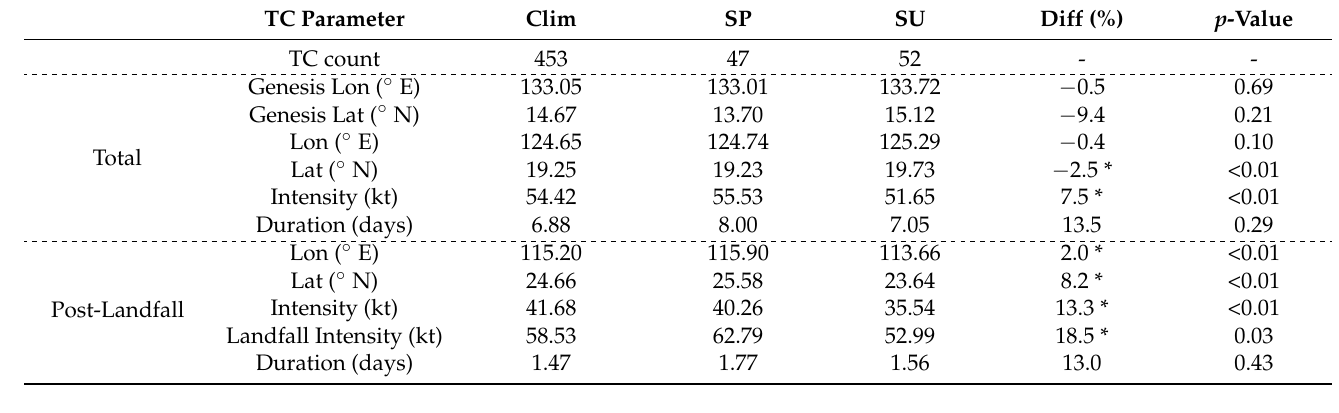
Table 1. The differences between the TC parameters of landfalling TCs in China during the typhoon season of SP and SU El Niño years. The total represents the entire track of each TC, and post-landfall represents the post-landfall track of each TC. The differences (sixth column) were the rates of change in SP El Niño years relative to SU El Niño years. A * indicates statistical significance at the 95% confidence level, based on the Wilcoxon–Mann–Whitney test. The p -value is the statistical significance of the last column.